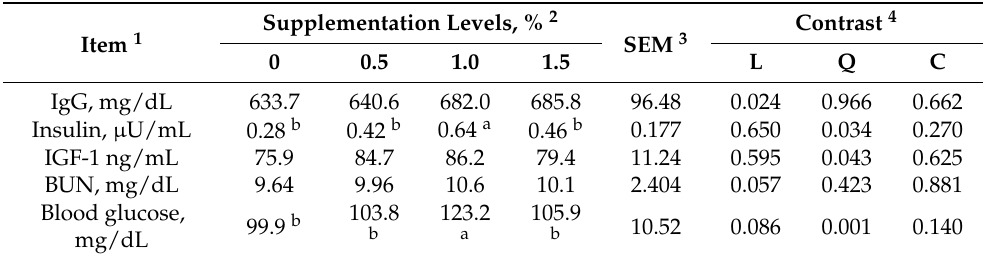
Table 5. Effects of microbial-additive supplementation on blood metabolites of weaning pigs fed for 21